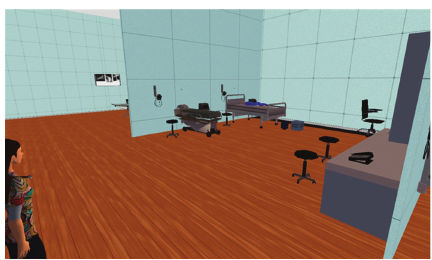
Figure 2: Second life patient care